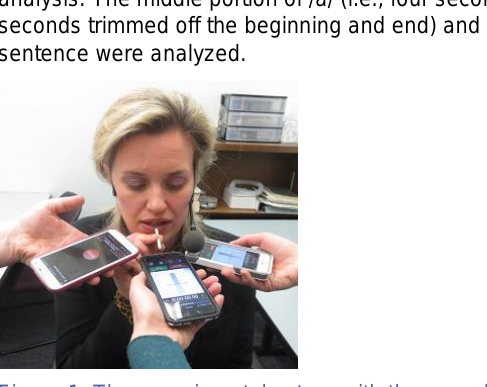
Figure 1. The experimental set-up with the recording devices (iPhone 5 and 6s, Samsung Galaxy S5, head mounted microphone) and the plastic stick that measured 4 cm from the mouth to the microphones.